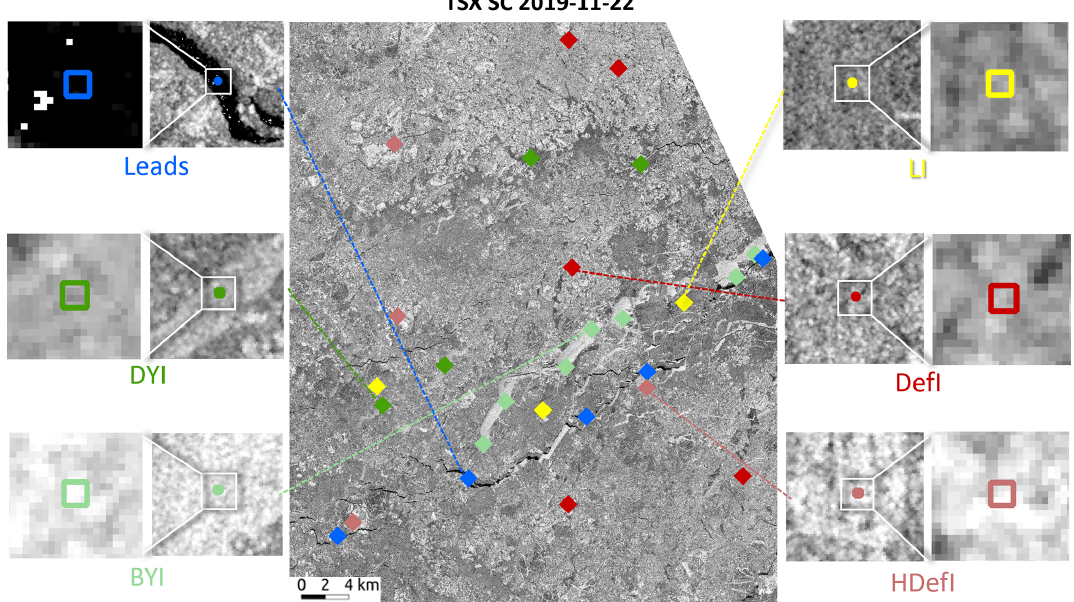
Figure 3. Example reference polygons of different classes over the scene on 22 November